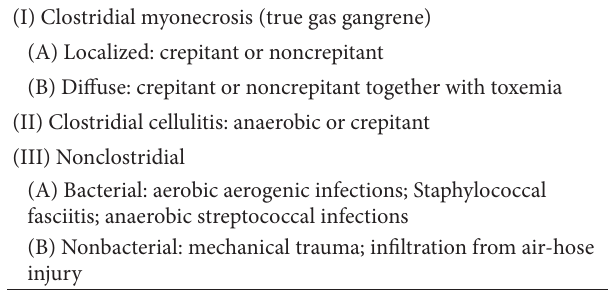
Table 3: Clinical consideration when gas gangrene is